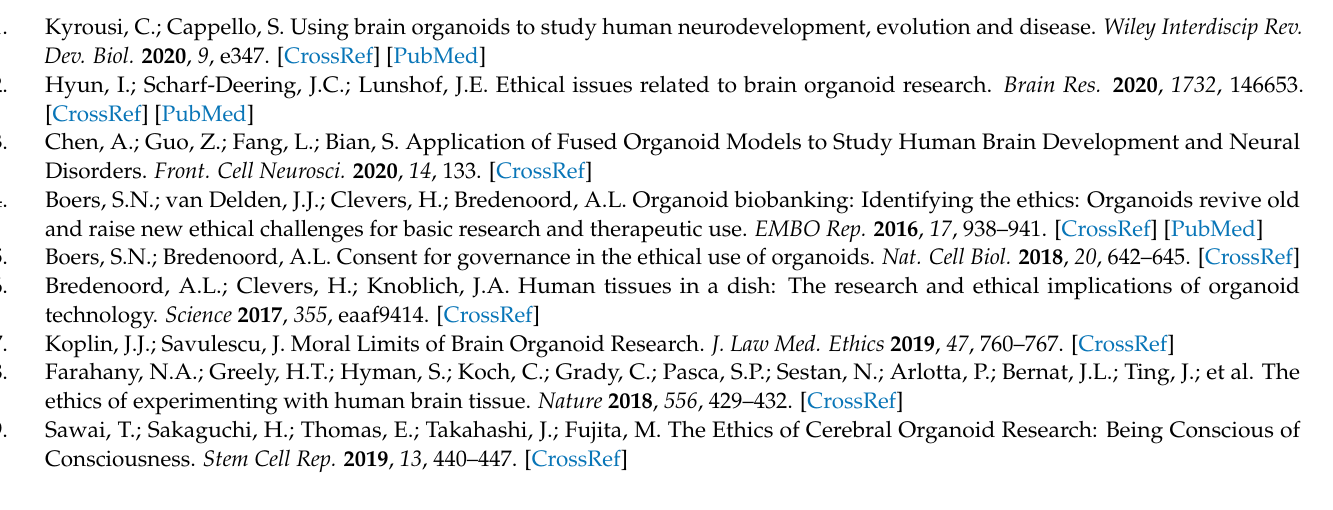
Figure 2 was created by Sarah Liza Higginbottom with BioRender.com (accessed on 30 January 2023). Conflicts of Interest: The authors declare no conflict of